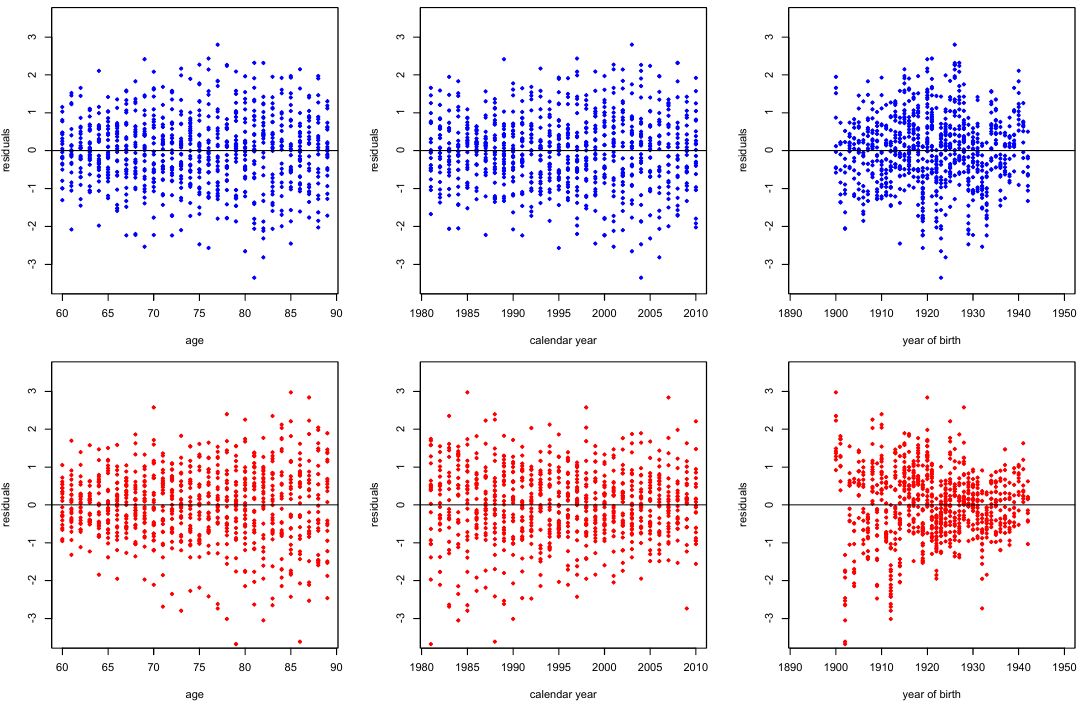
Figure 8. Residuals deviance of M 1 for males ( top panels) and females ( bottom panels) in Greece. Period 1981–2010, ages